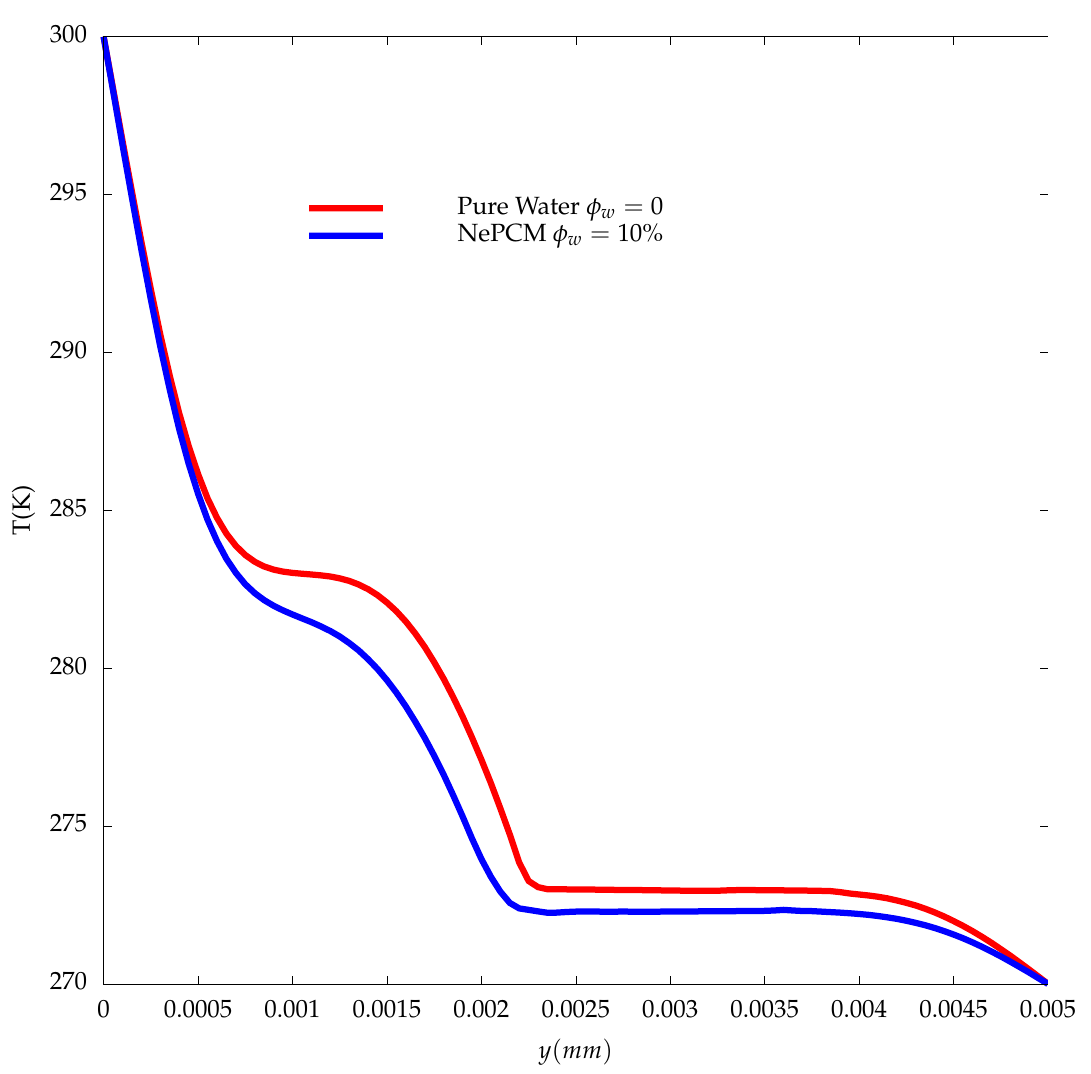
Figure 9. Compression between the Temperature evolution along vertical line located at x = 0.005 mm, and a long the y -axis for the case of φ w = 0, and